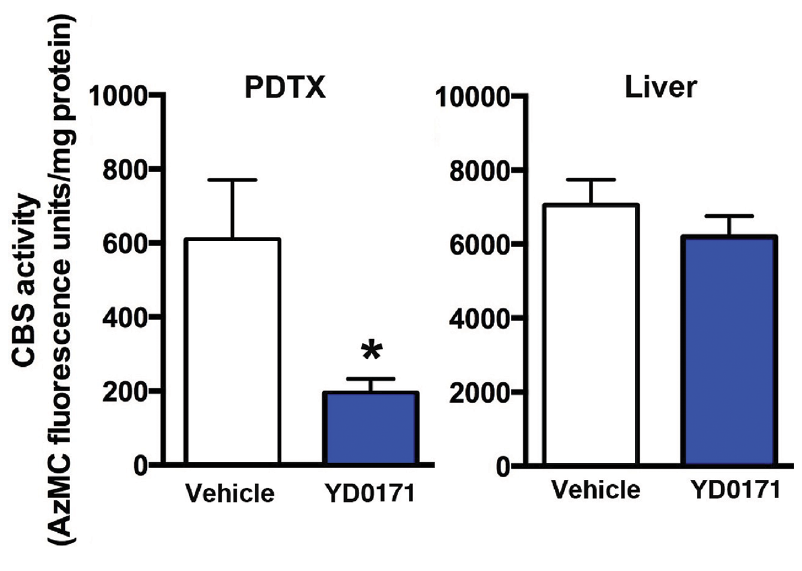
S production in HCT116 tumors of nude mice. Mice were sub- Figure 16. YD0171 inhibits H 2 jected to implantation of PDTX of a colon cancer patient. When the tumor reached the size of 1,000 mm 3 , treatment with vehicle or YD0171 (3 mg/kg/d) started and continued for 7 d, at which point tumors were excised and liver tissues were collected. Tissues were homogenized and CBS-mediated H S production was measured by the AzMC method. 2 CBS activity was reduced by YD0171 (* p < 0.05) in the tumor tissue, but no significant inhibition was detected in the liver tissue. Data are shown as mean ± SEM values of n = 4 animals per group.